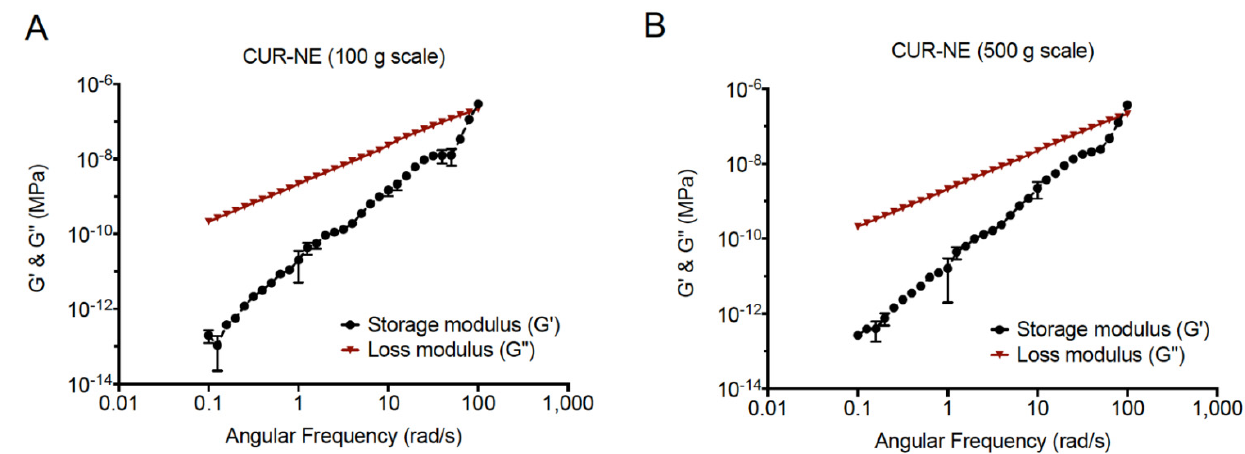
Figure 9. Dynamic viscoelastic curves presenting the variation of storage moduli and loss moduli with angular frequency of ( A ) 100 g CUR Nanoemulsion and ( B ) 500 g CUR Nanoemulsion at 25 ◦ C. Data collected on DHR-20 Rheometer. Experiments ran in triplicate. Data presents average ± SD. Data was processed using the TRIOS software and plotted using Graph Pad Prism 8.